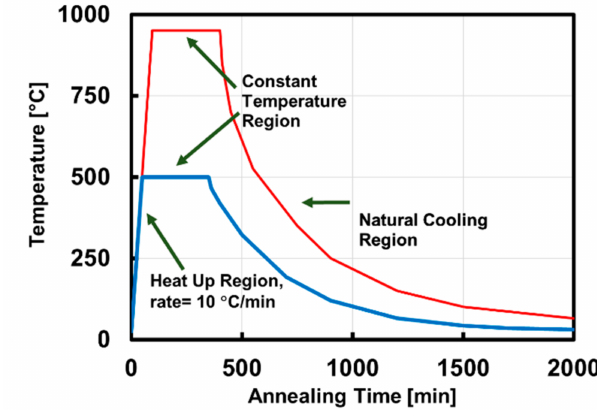
Figure 3. Profile of the thermal treatments applied in the third step of the CuIC thin film fabrication